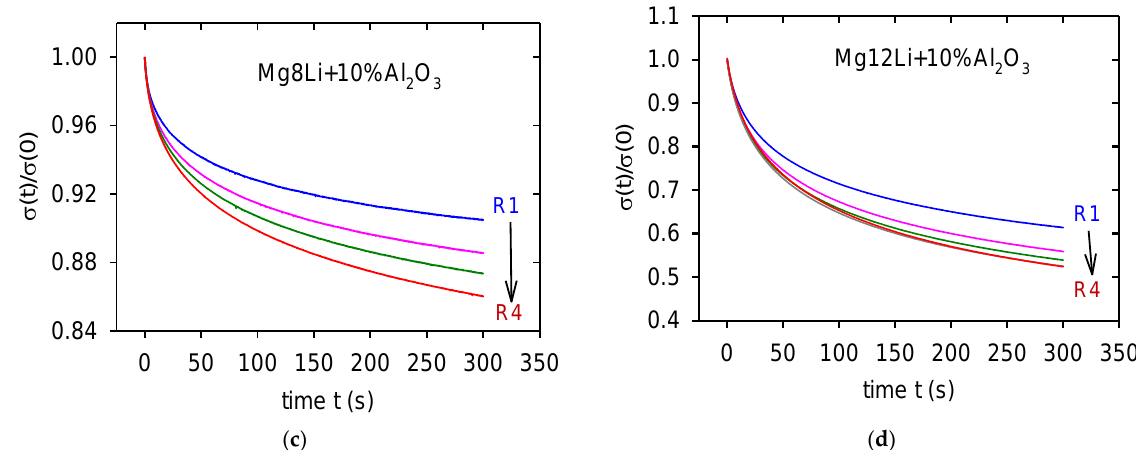
Figure 4. The sequences of stress-relaxation curves obtained for ( a ) Mg, ( b ) Mg4Li, ( c ) Mg8Li, and ( d ) Mg12Li alloys with 10 vol % Saffil fibers.